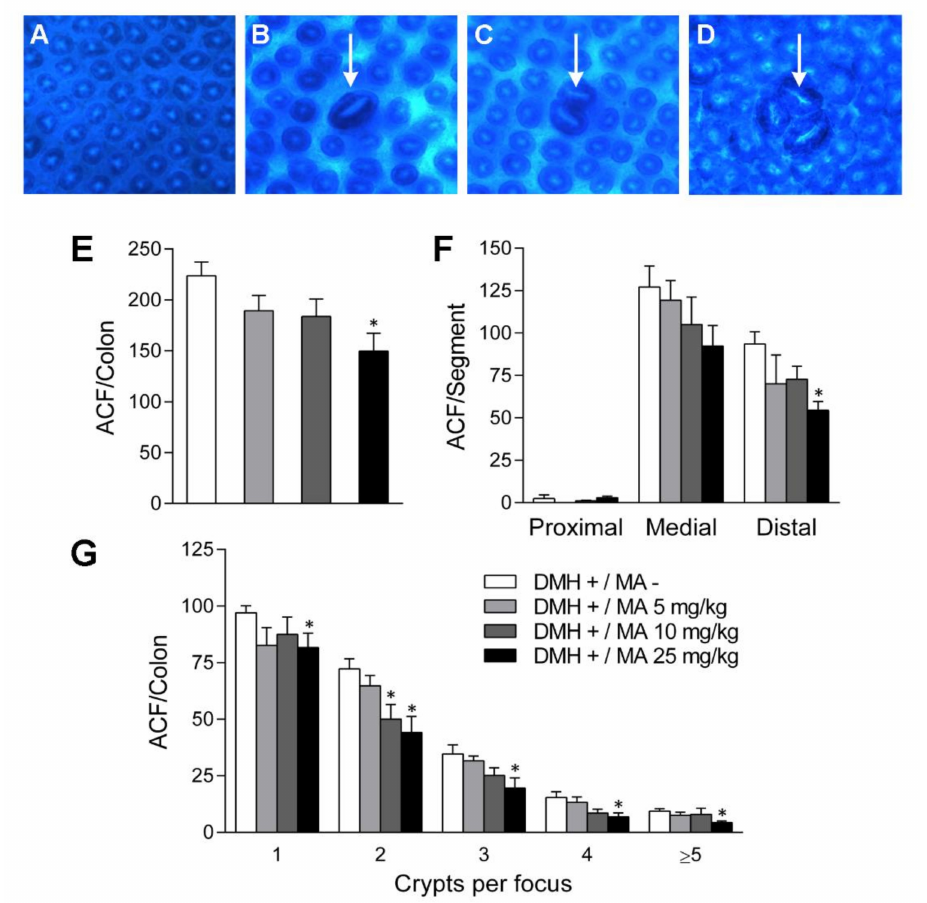
Figure 4. Aberrant crypt foci (ACF) observed under a light microscope after staining of the colon with methylene blue (magnification of × 10). The images show the whole mount colon of animals in ( A ) the negative control (DMH − /MA − ) and the positive control (DMH − /MA+) showing a topographic view of ACF indicated by a white arrow, with one ( B ), two ( C ) or three crypts ( D ). The effects of maslinic acid at the doses of 0, 5, 10 and 25 mg/kg on the number of ACF in ( E ) total colon; ( F ) colonic segments and ( G ) number of crypt per focus in total colon. Results are expressed as mean ± SEM and were analyzed by the non-parametric Kruskal–Wallis test, followed by Dunn’s multiple comparisons test, n = 6–8. Asterisks indicate different from the control group: * p <